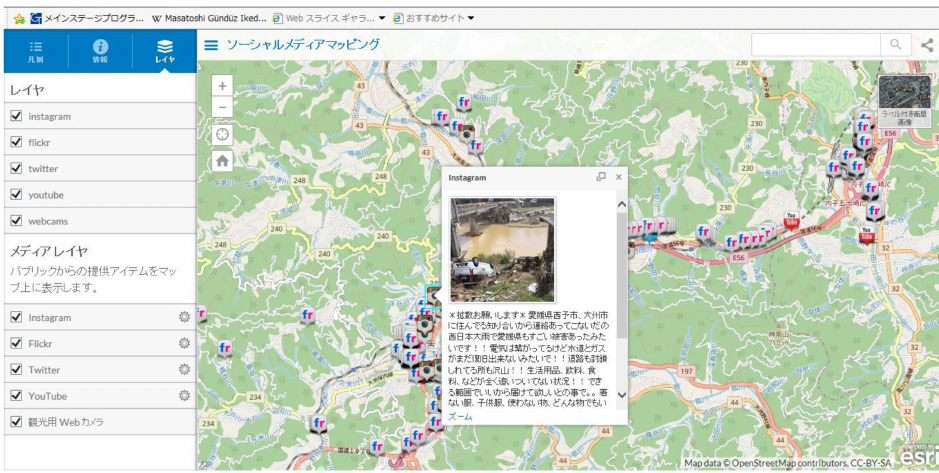
Figure 8. Submissions on YouTube concerning Fukuyama City, Hiroshima Prefecture.